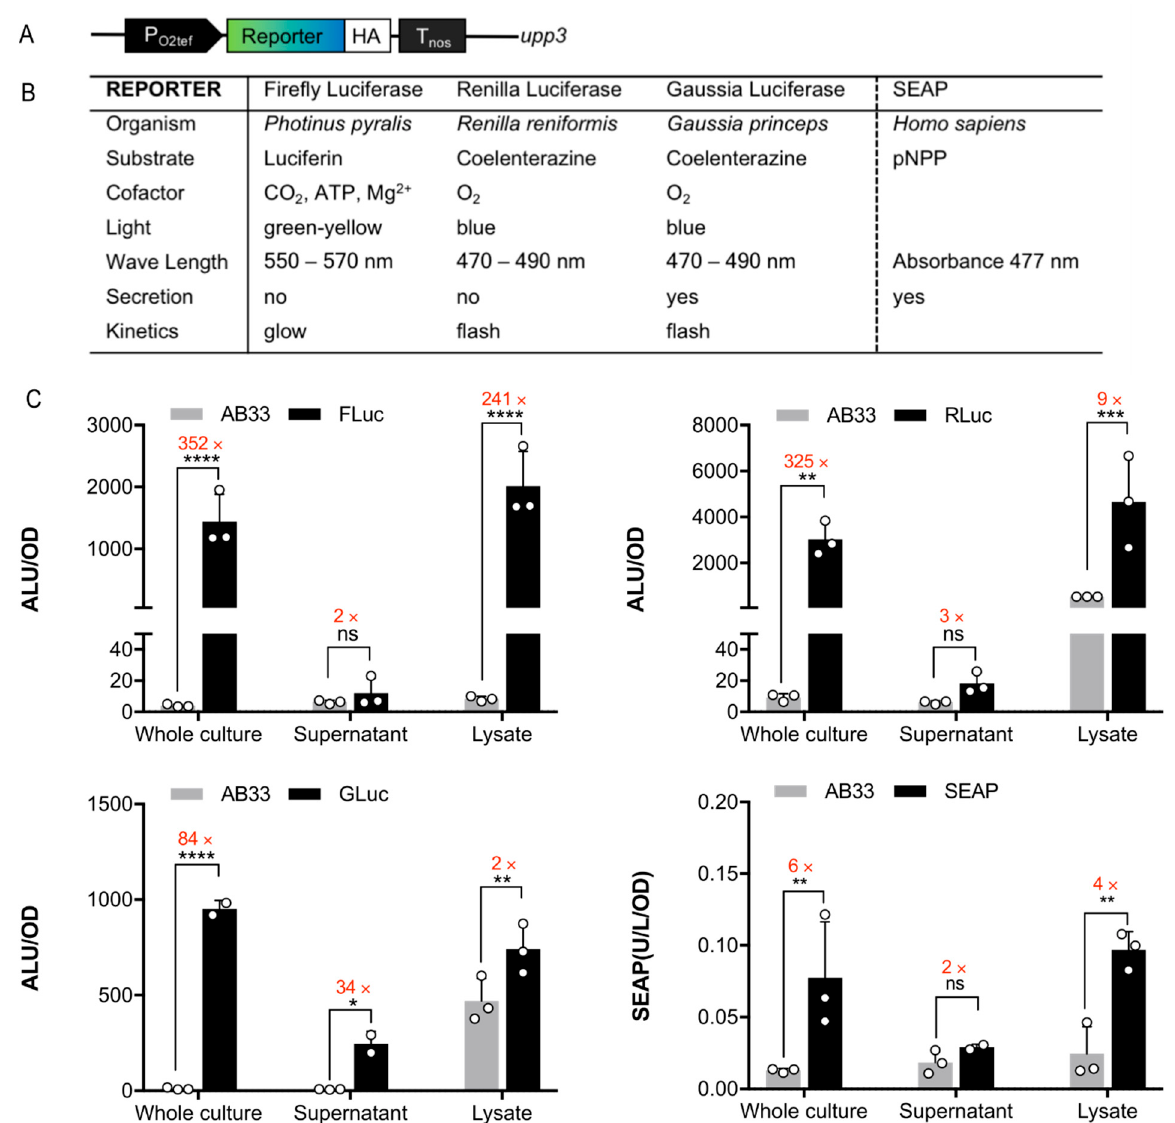
Figure 1. Quantitative reporter gene expression in U. maydis . ( A ) Molecular configuration of the constructs transformed for stable integration into the upp3 locus of the AB33 wildtype strain. The reporter genes were expressed under a constitutive promoter (P O2tef ). HA, synthetic peptide tag for Western blot analysis; T nos , nos terminator. ( B ) Description and parameters of the selected reporter genes. ( C ) Quantitative characterization of reporter gene activities. Whole-cell culture, supernatant, and lysate of 80 µ L culture were analyzed in all reporter strains, and the original AB33 WT strain served as a negative control. Upper left , FLuc luminescence after addition of D-luciferin; upper right, RLuc luminescence after addition of 1:15 diluted coelenterazine in PBS; lower left, GLuc luminescence after addition of 1:1500 diluted coelenterazine in PBS; lower right, SEAP activity after addition of 4-nitrophenyl phosphate (pNPP). Luminescence is given as absolute luminescence units (ALU) and normalized to OD 600 = 0.5. Error bars, s.d. (n = 3). *, p < 0.05; **, p < 0.001; ***, p < 0.0002; ****, p < 0.0001; ns, not significant (one-way